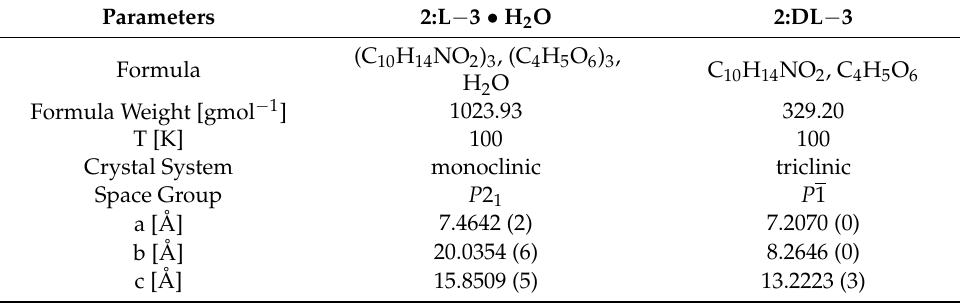
Table 5. Crystallographic data obtained by SCXRD measurements of 2:L − 3 • H 2 O and 2:DL − 3